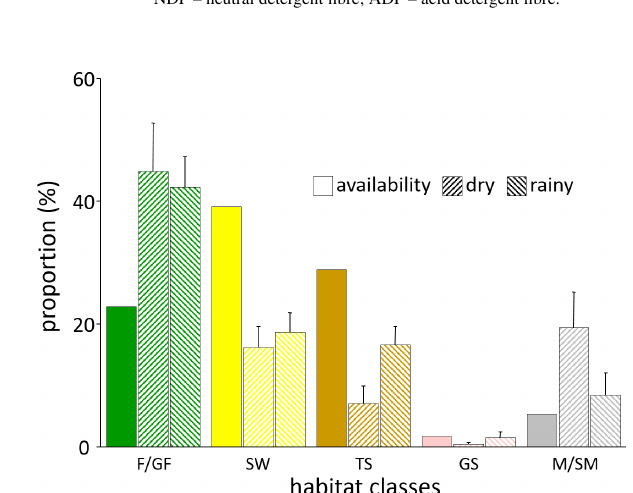
Figure 11. Habitat availability and habitat use of Guinea baboons in Simenti. Availability: proportion of habitat classes allocated within the area of interest. Use by baboons in dry and rainy season: pro- portion of location points of individual baboons within respective habitat classes in dry and rainy seasons. Individual variability in habitat use is displayed as the standard error. F/GF – forest/gallery forest; SW – savannah woodland; TS – tree savannah; GS – grass- land; M/SM – Mare, seasonal